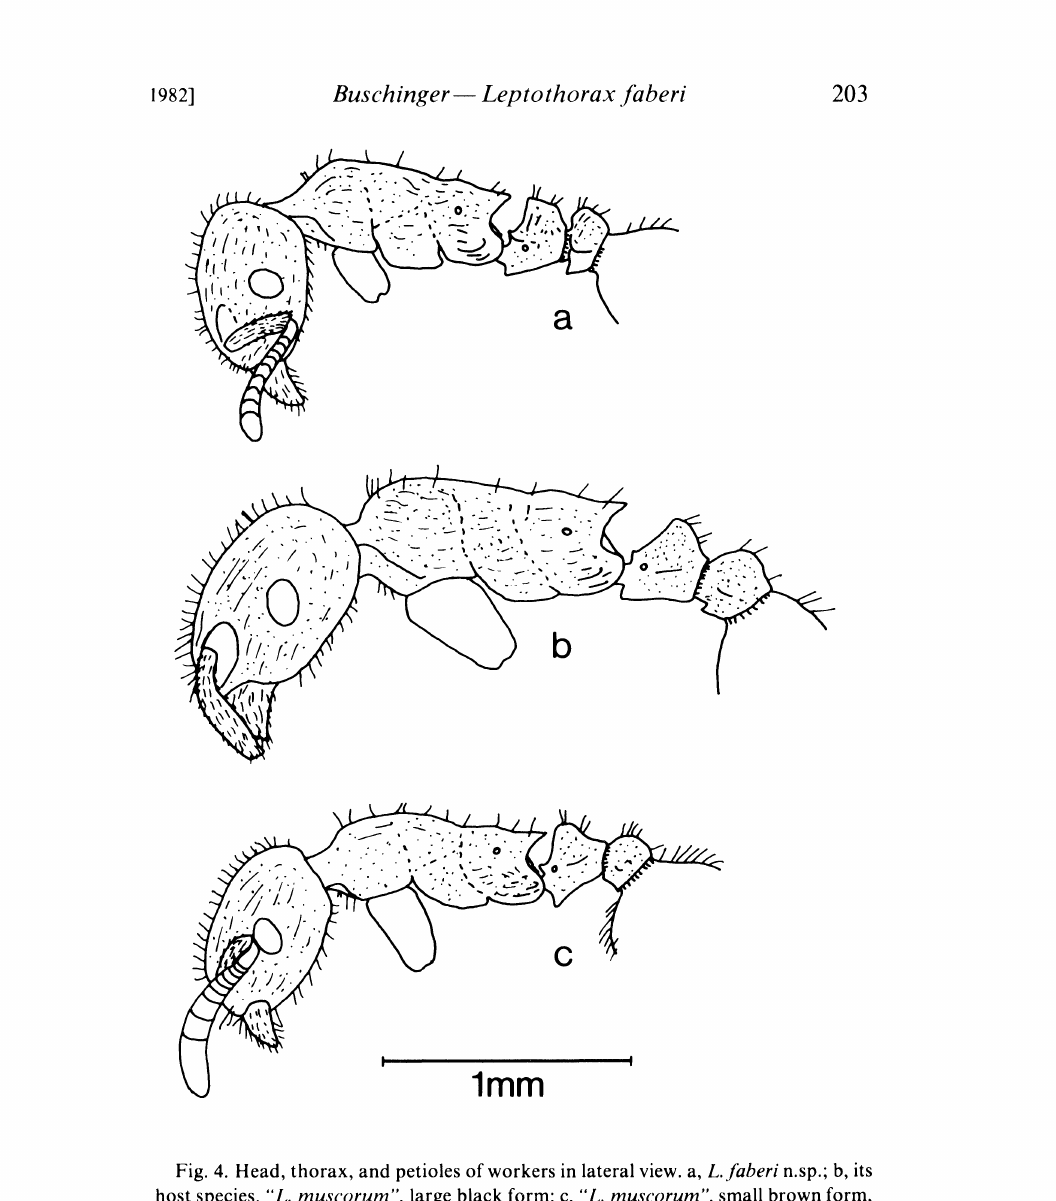
Fig. 4. Head, thorax, and petioles of workers in lateral view. a, L. faberi n.sp.; b, its host species, "L. muscorum", large black form; c, "L. muscorum", small brown form, for